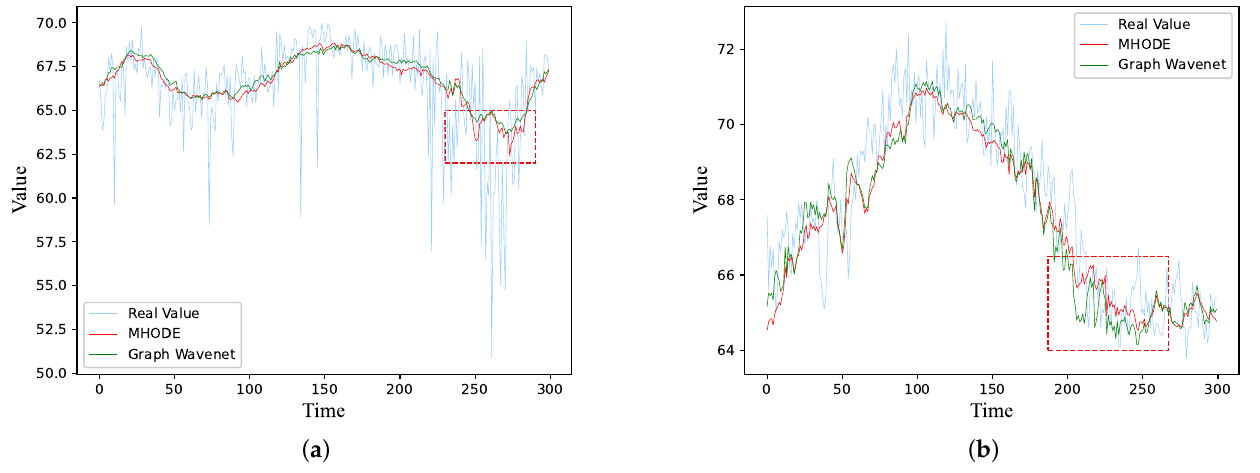
Figure 8. Comparison of prediction curves for 60-min advance predictions on snapshots of test data: ( a ) the comparison of prediction curves for MHODE and Graph Wavenet on METR-LA; ( b ) the comparison of the prediction curves of MHODE and Graph Wavenet for